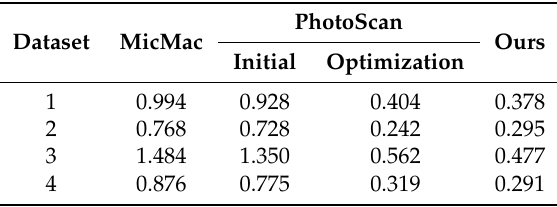
Table 9. Relative accuracy for bundle adjustment tests without GCPs (in pixels).